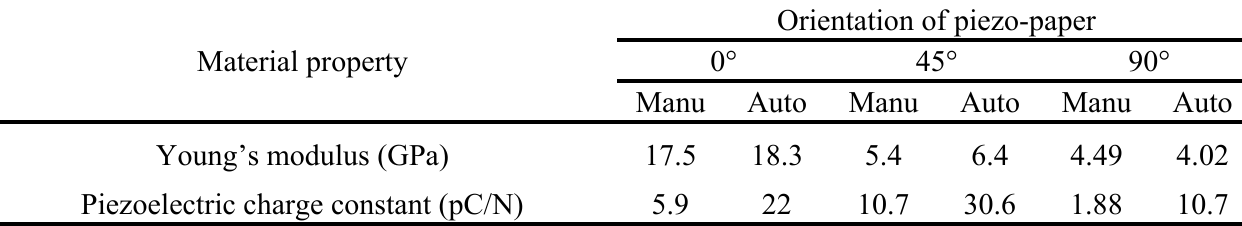
Table 1. Characteristics of piezo-paper depending on orientation and manufacturing process.